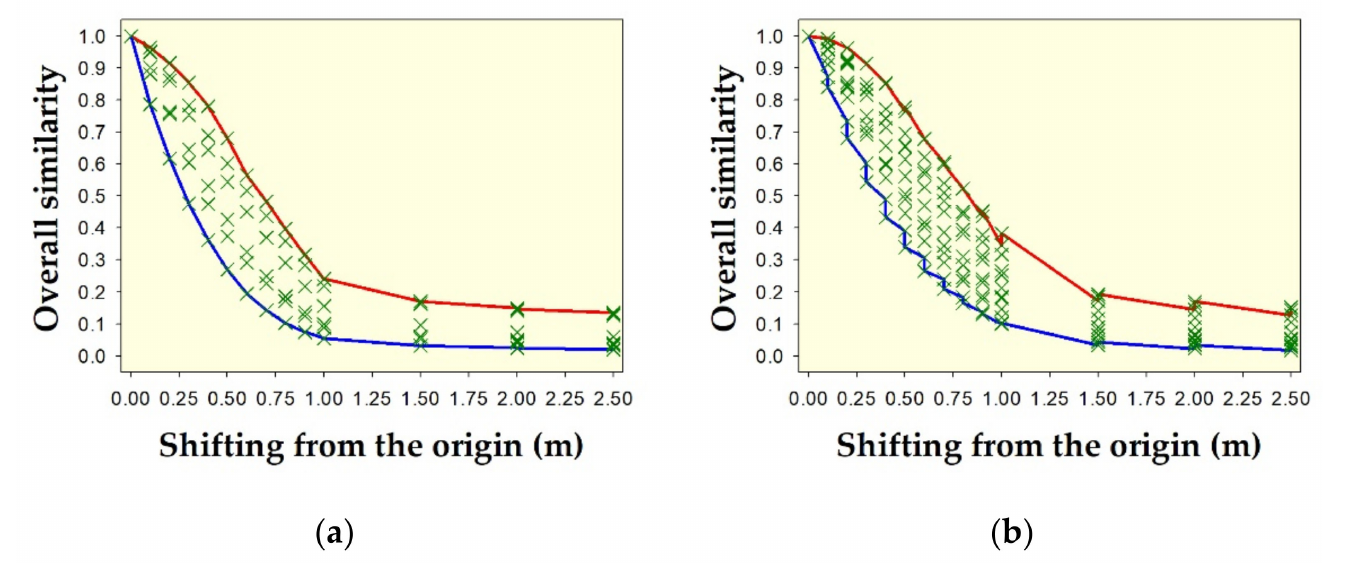
Figure 13. Overall spatial pattern similarity (i.e., the average of similarity of θ and similarity of δ ) for two hypothetical shapes: ( a ) circle with diameter of about 1.0567 m, and ( b ) square with dimensions of 1.0567 × 1.0567 m 2 , due to shifting from the origin in all directions. Green crosses indicate overall similarity from all nine metrics. Red lines on the upper edge of the envelopes indicate the overall similarity using the Fidelity metric. Blue lines on the lower edge of the envelopes indicate the overall similarity using the metric of